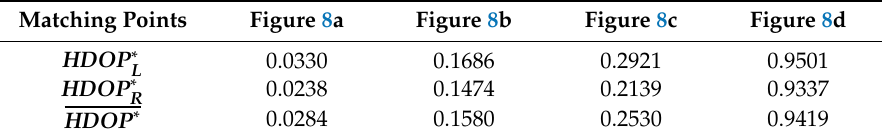
Table 3. The results calculated by the matching points in Figure 8.